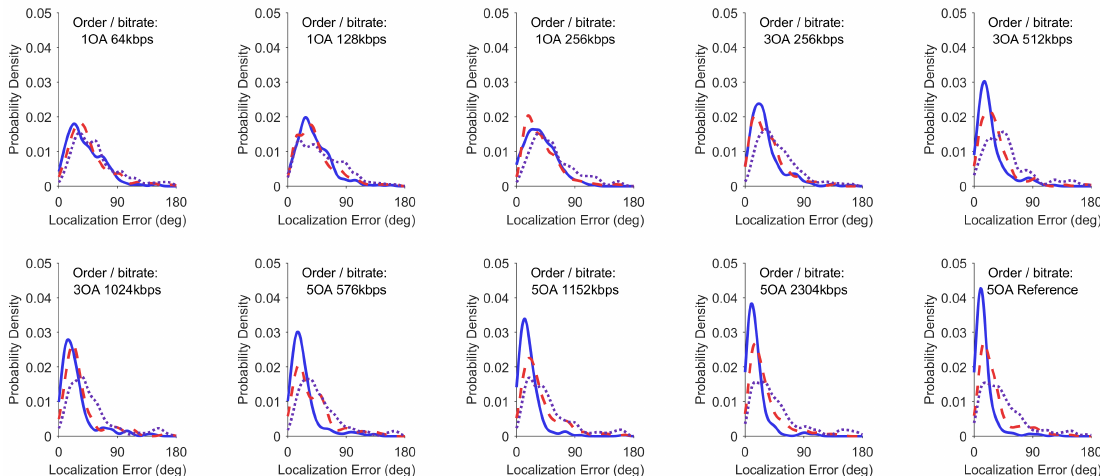
Figure 7. Probability density functions of the localization error for different spatial audio rendering methods at different codec bitrates and Ambisonic orders. Continuous line represents loudspeaker reproduction, dashed line—binaural (individual HRTFs), dotted—binaural (generic HRTFs). Kernel bandwidth: BW = 6. HRTFs: Head-Related Transfer